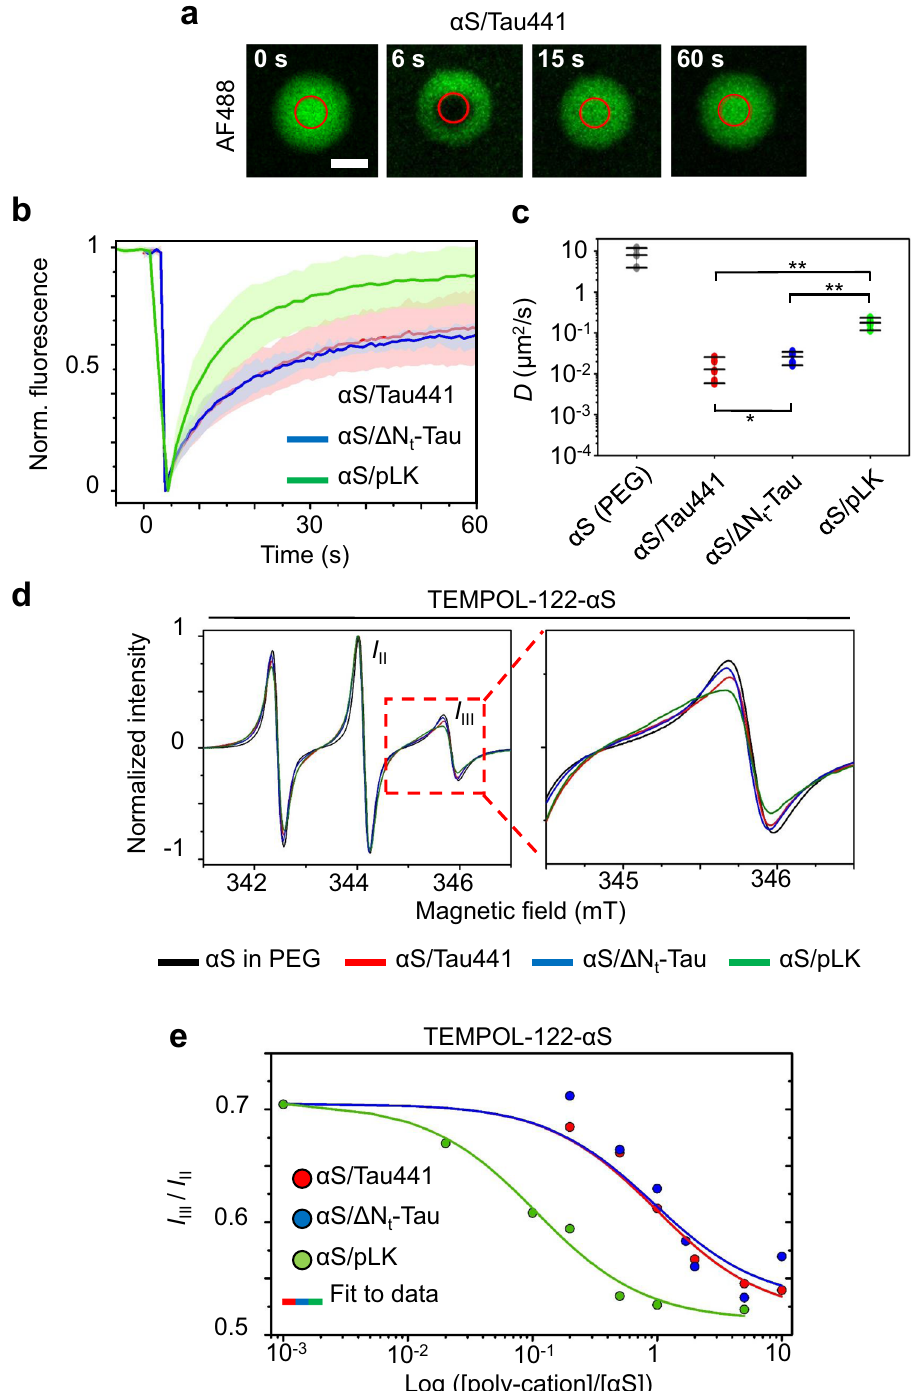
Fig. 3 | α S dynamics in electrostatic complex coacervates. a – c FRAP analysis of α S dynamics (2% AF488-labeled α S) within electrostatic coacervates. Representa- tive images of a triplicate α S/Tau441 FRAP assay are shown in ( a ), where the red circle indicates the bleached area. Scale bar is 5 μ m. b Mean FRAP curves and ( c ) calculated diffusion coef fi cients ( D ) of 5 – 6 (N) different droplets from a triplicate experiment with 100 μ M α S and equimolar concentrations of Tau441 (red) or Δ N t - Tau (blue) or tenfold concentration of pLK (green) under LLPS conditions. The standard deviations of the FRAP curves are shown as shaded colors. For compar- ison, the diffusion coef fi cient of α S in the dispersed phase was determined in triplicateby fl uorescencecorrelationspectroscopy(FCS)(seeSupplementaryFig.3